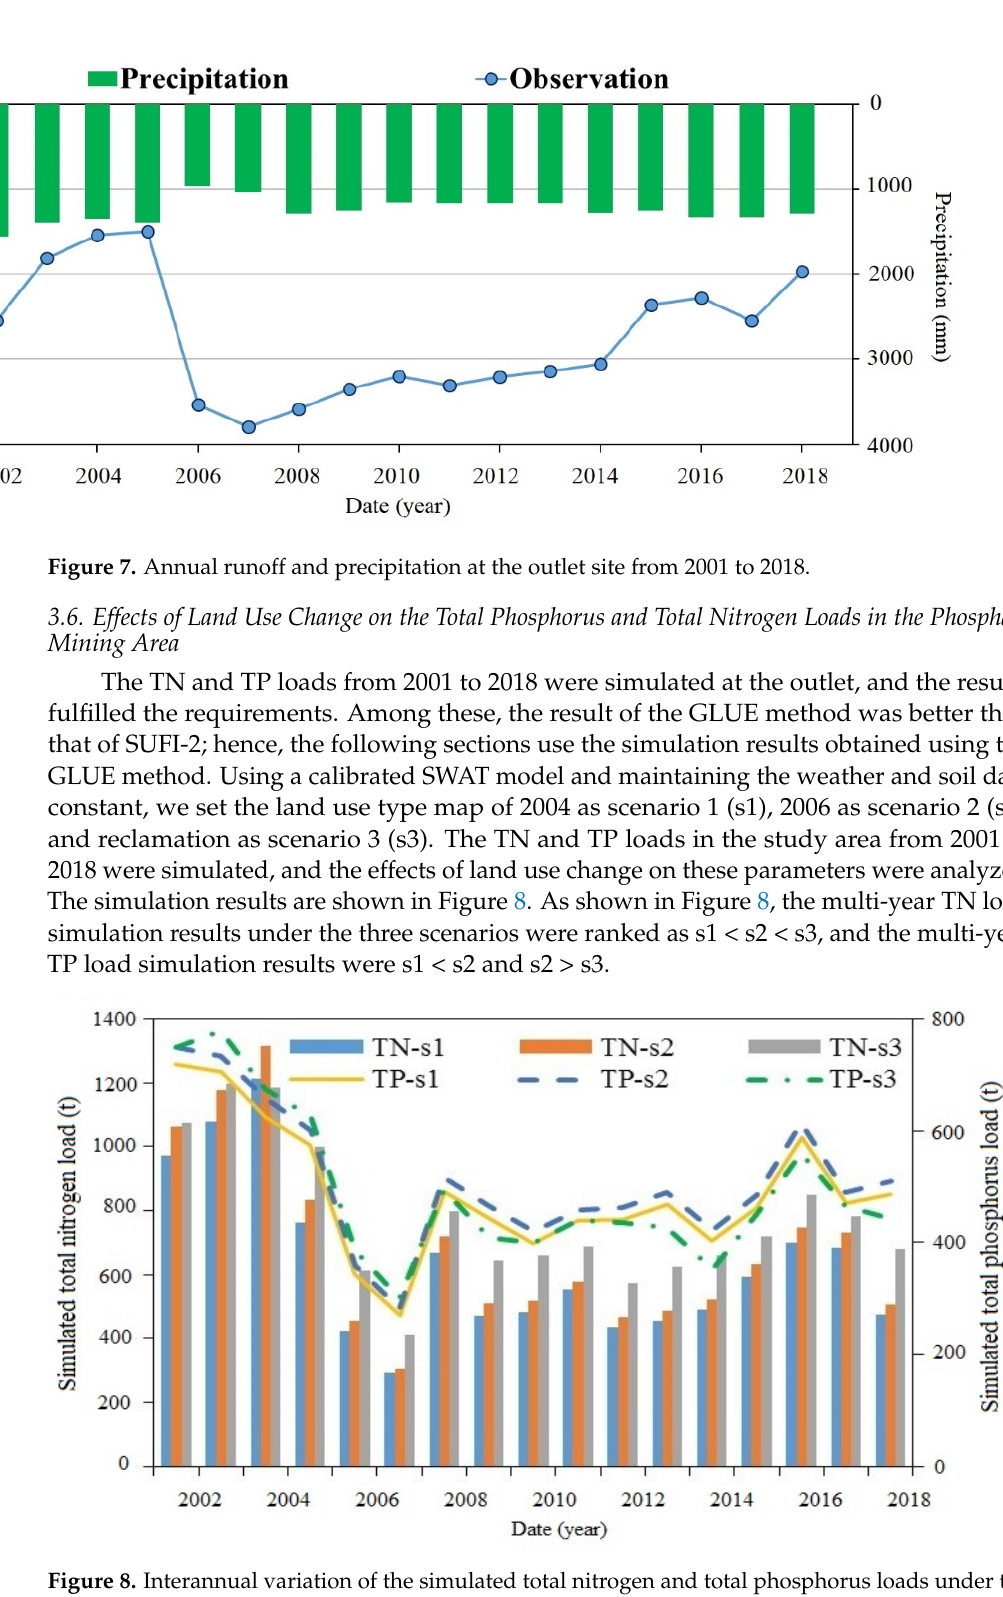
Figure 8. Interannual variation of the simulated total nitrogen and total phosphorus loads under the three land use scenarios.